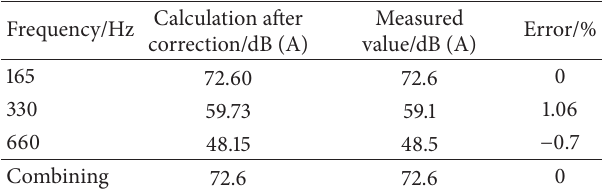
Table 6: Comparation between calculated and measured values of Sound power